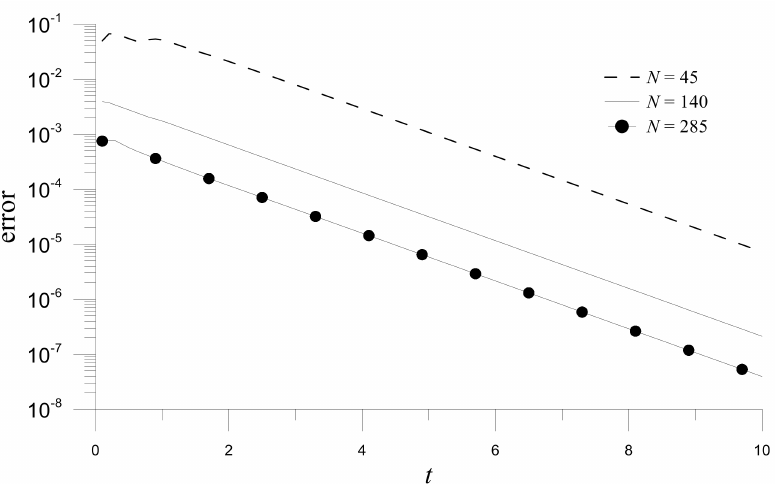
Figure 19. Time histograms of errors for numerical solutions obtained by the Hermite MAPS with different numbers of collocation points in Example 5 ( ∆ t = 0.01 and θ = 1 ).